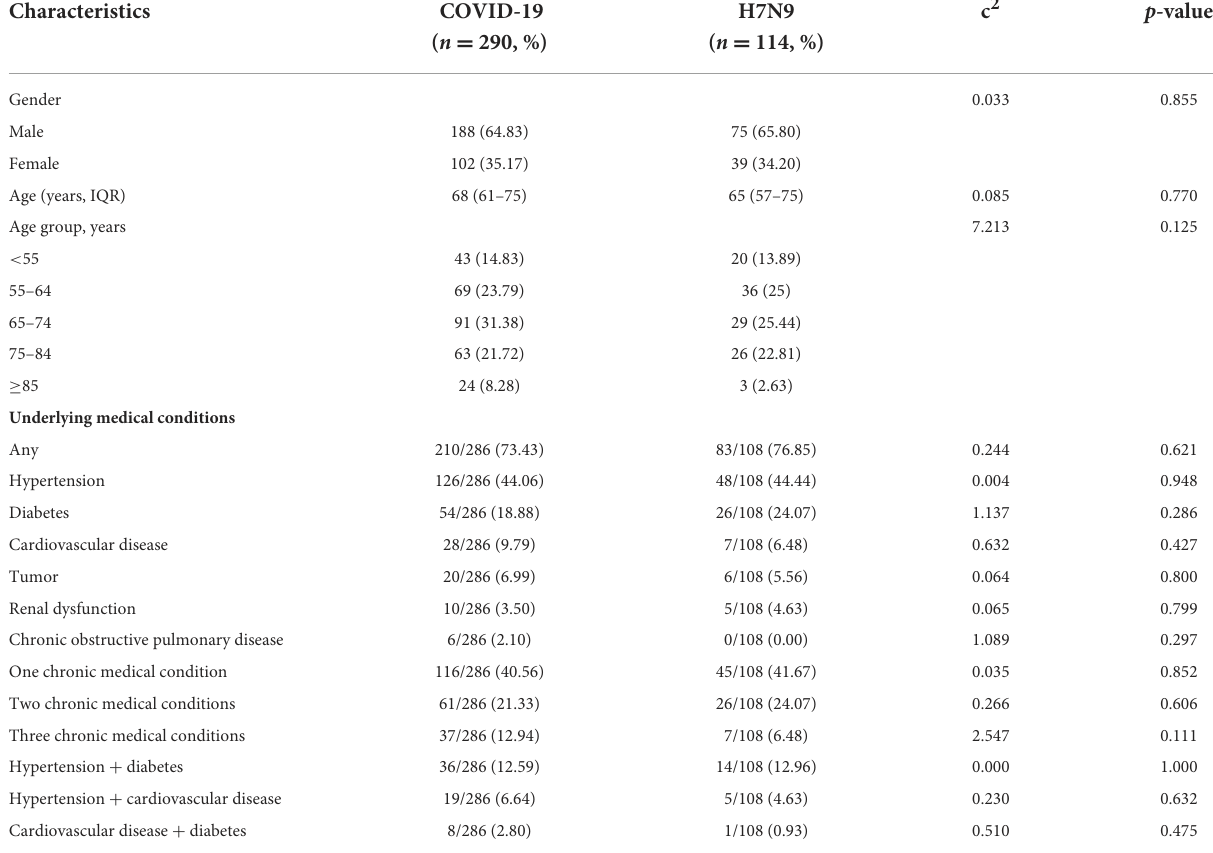
TABLE 1 Demographics and underlying medical conditions in fatal cases with COVID-19 and H7N9.